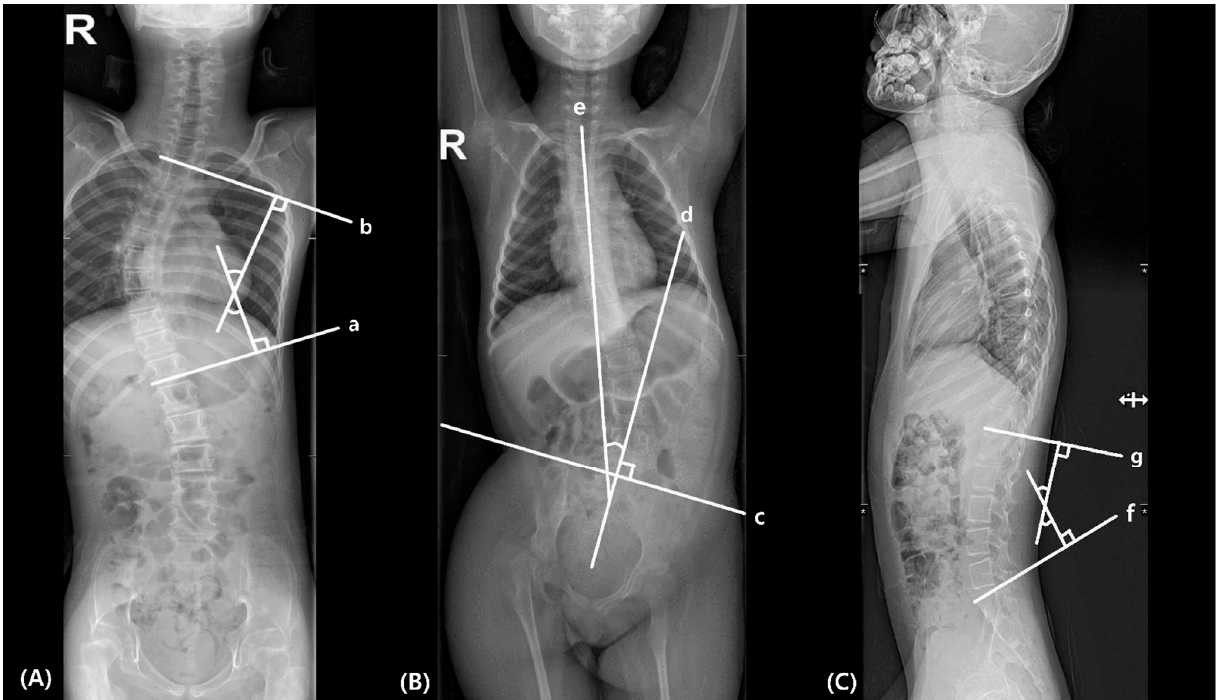
Figure 1. Measurement of ( A ) scoliosis, ( B ) pelvic obliquity and ( C ) lumbar lordosis. (a) The inferior endplate of the lowermost vertebral body in scoliosis curvature; (b) the superior end plate of the uppermost vertebral body in scoliosis curvature; (c) line connecting the bilateral iliac crests; (d) per- pendicular line to the line connecting the bilateral iliac crests; (e) line between the center of T1 to S1 vertebral bodies; (f) S1 superior endplate line; (g) T12 inferior endplate